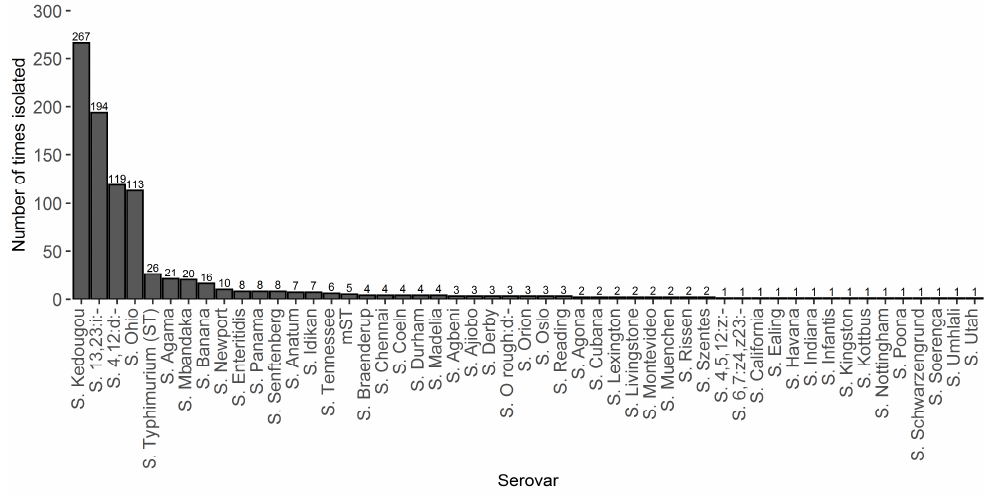
Figure 2. Number of times each Salmonella serovar was isolated across all 31 mill visits. The number of different serovars isolated from each Salmonella -positive mill at the first visit ranged from 1 to 11, with a mean value of four. Across all the mill visits, two mills yielded only one serovar whilst six mills had more than five serovars isolated. Of the mills receiving repeat visits, the number of serovars isolated did not differ greatly between visits (Figure 3). Among these mills, persistent serovars dominated the isolates, with the exception of F4 and F5, where the resident serovar was isolated infrequently and intermittently (Table 3). Different serotypes ( S. Kedougou, S. 13,23:i:-, S. 4,12:d:- and S. Ohio) dominated across the different sampling locations, with S. Kedougou dominating in 12 of the 18 locations throughout the ingredient, processing, treatment, and environ- mental areas; see Supplementary Material–Table S3.